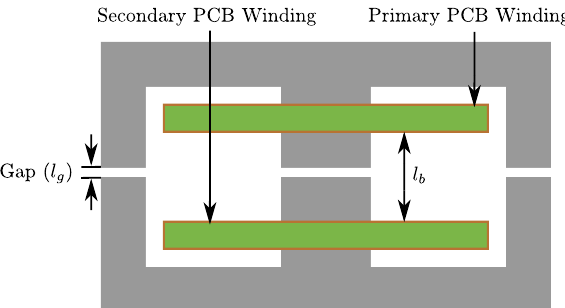
Figure 5. Structure of the planar transformer with adjustable leakage and magnetizing inductance. L g (for adjusting the magnetizing inductance and leakage inductance) is the air gap and L b (for adjusting the leakage inductance precisely) is the distance between the primary and secondary windings. Reproduced with permission from [1], IEEE,